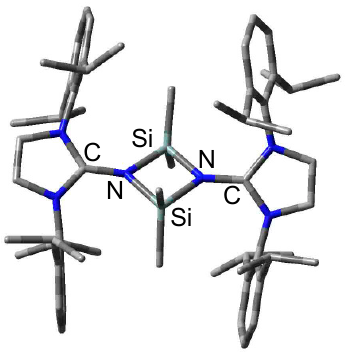
Figure 2. Calculated structure of 2 .